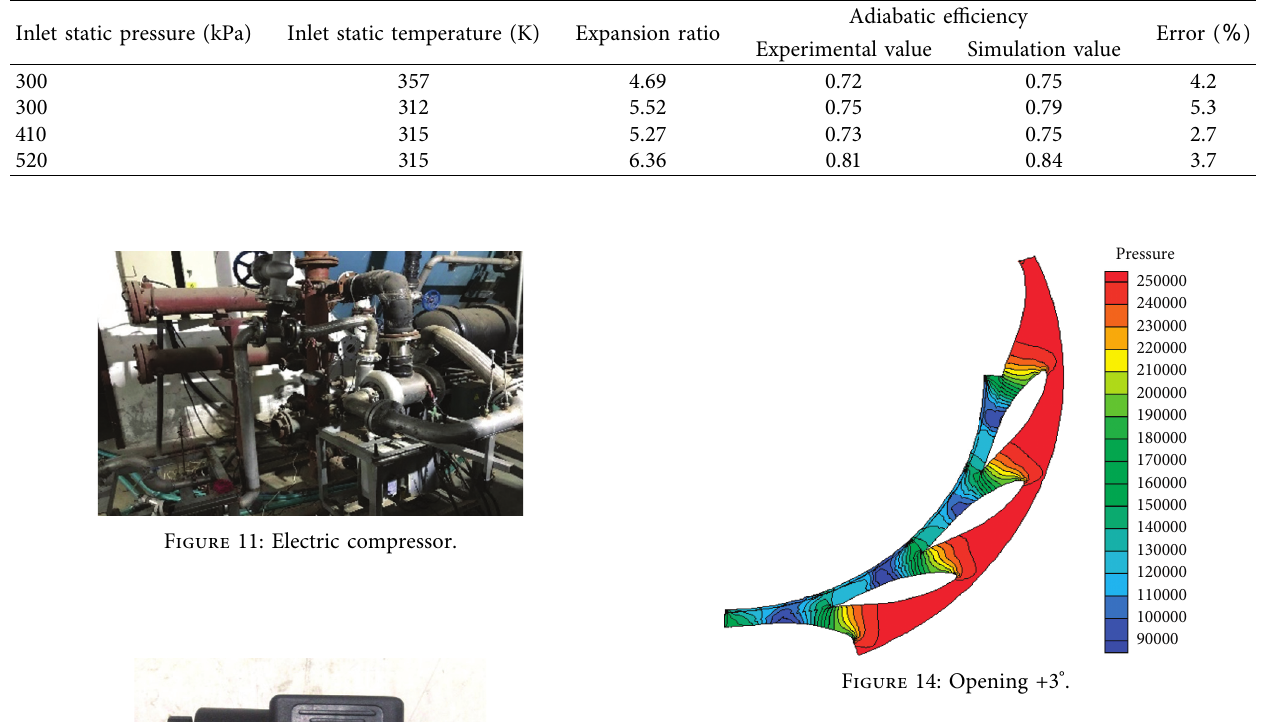
Figure 14: Opening +3 ° .